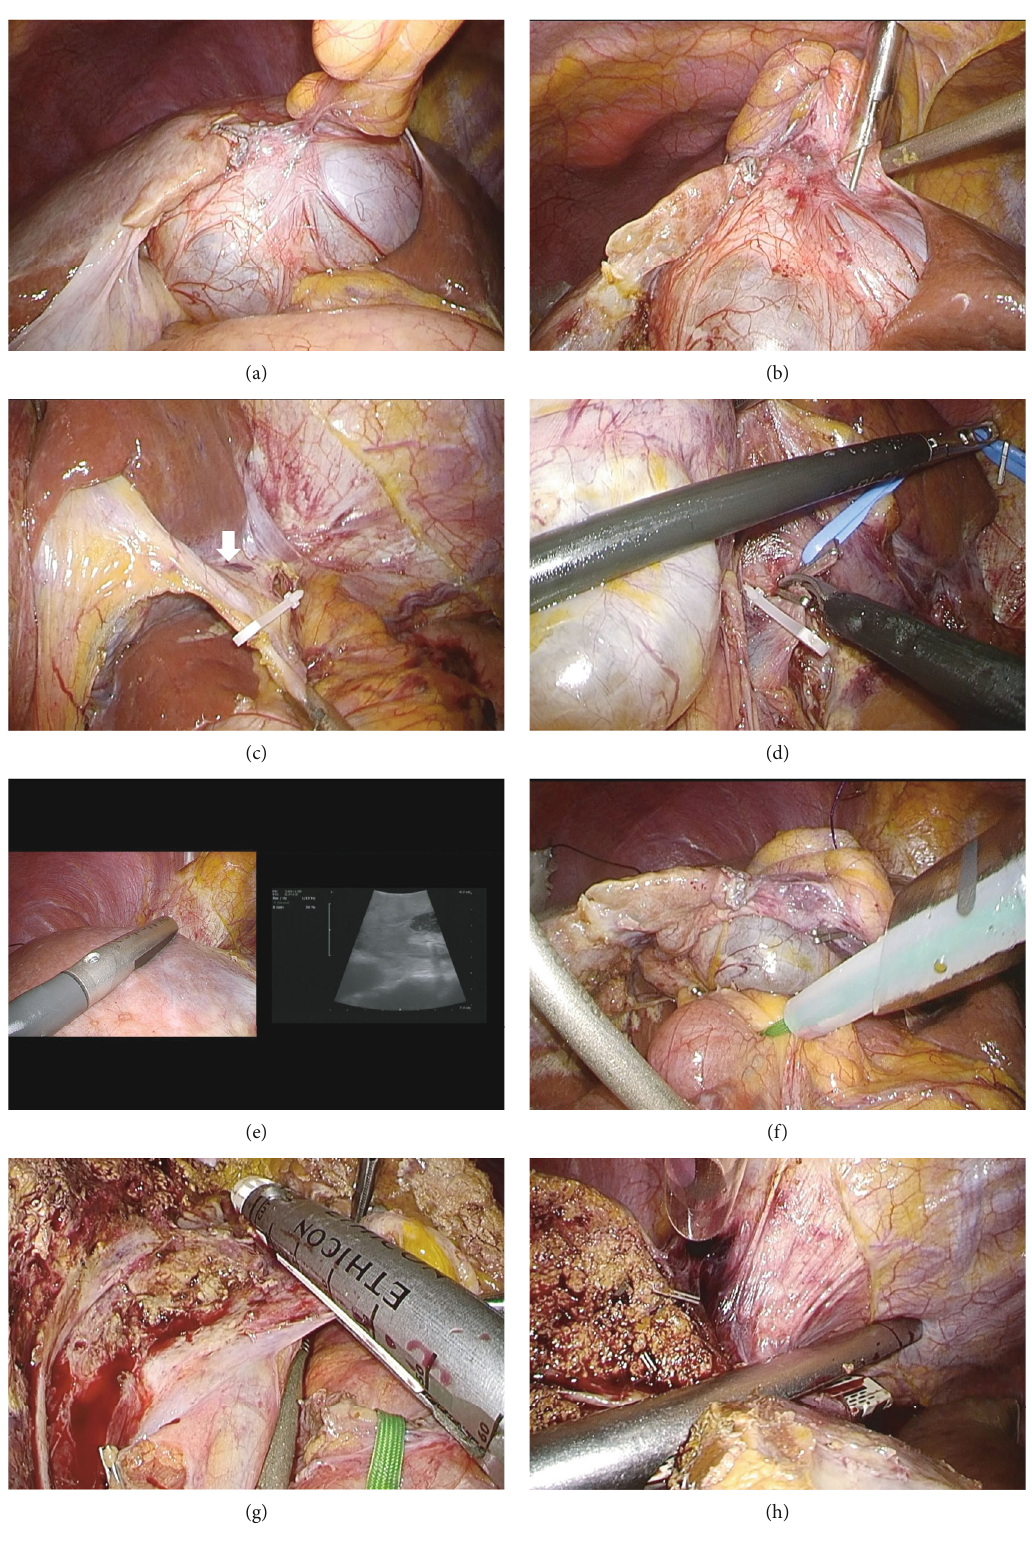
Figure 4: Surgical method is shown. A regrowth tumor was observed in the medial segment of the liver (a). Aspiration of cystic fl uid was performed to secure a fi eld of view (b). The left hepatic artery (white arrow) was diverged from the left gastric artery and clipped (c). The left portal vein was identi fi ed and divided after clipping (d). The transection line was set using intraoperative ultrasonography (e). Pringle ’ s maneuver was performed prior to hepatic parenchyma transection (f). The (g) left hepatic duct and the (h) left hepatic vein were divided by a linear